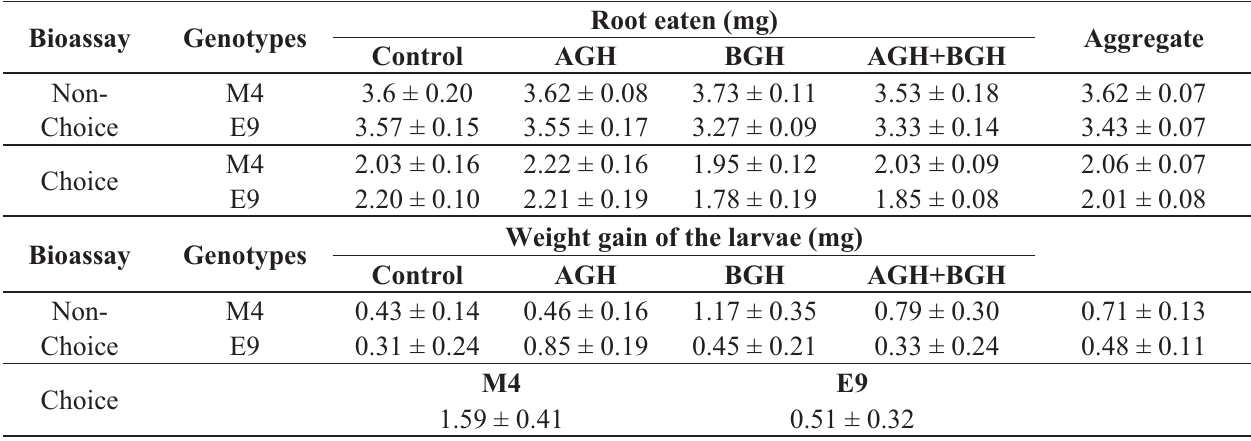
Table 2. Total amount of roots eaten in mg (mean ± SE) and weight gain of the larvae in mg (mean ± SE) by Agriotes larvae in choice and non-choice feeding